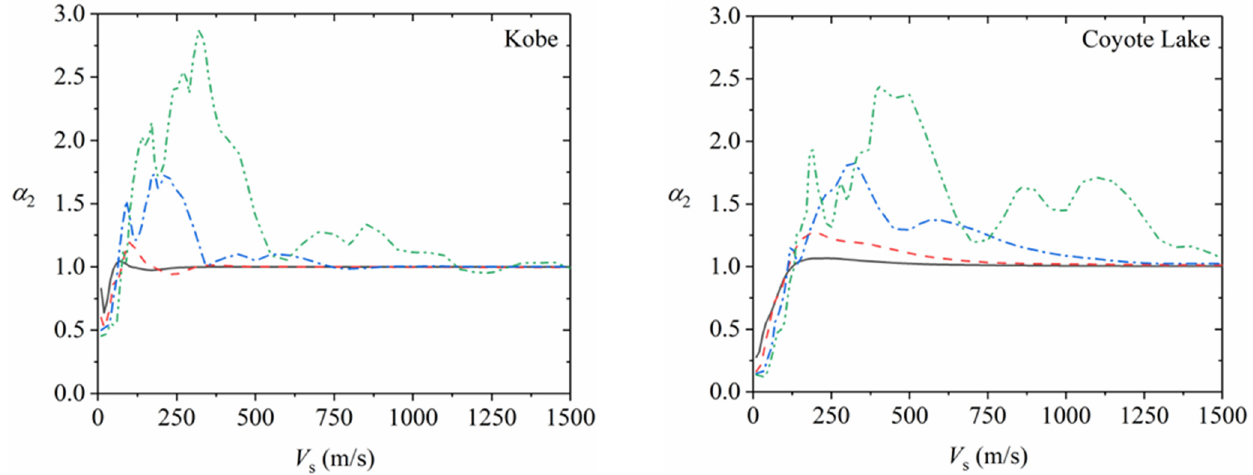
Figure 15. Ratio of the hydrodynamic shear under flexible soil to that under rigid soil for V s . Figure 16. Ratio of the hydrodynamic moment under flexible soil to that under rigid soil for V s .